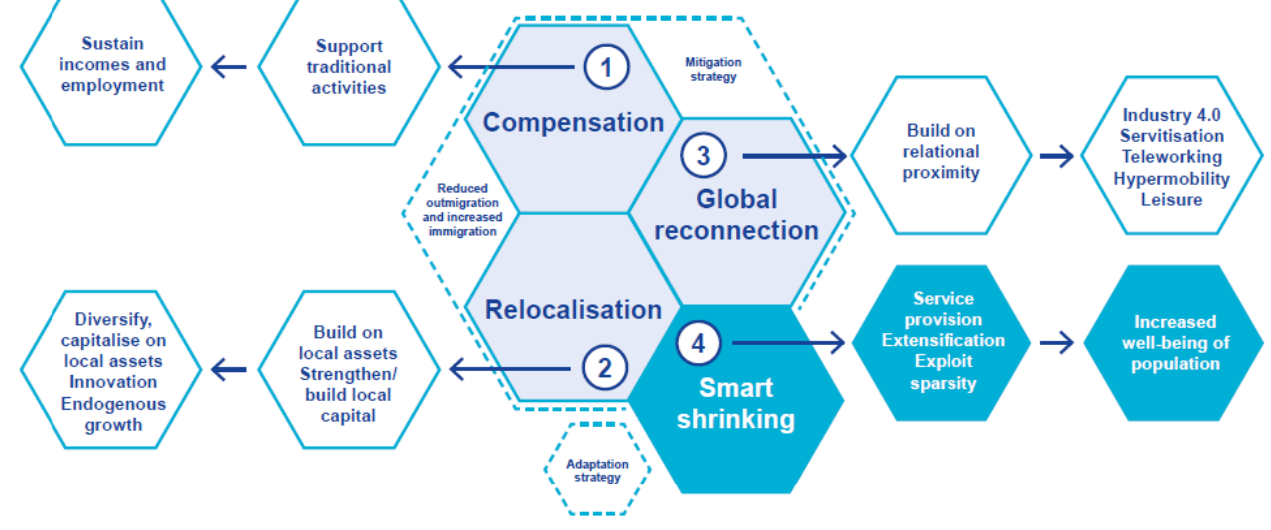
Figure 1. Redesigned framework for policy to address complex shrinking [96] (p.